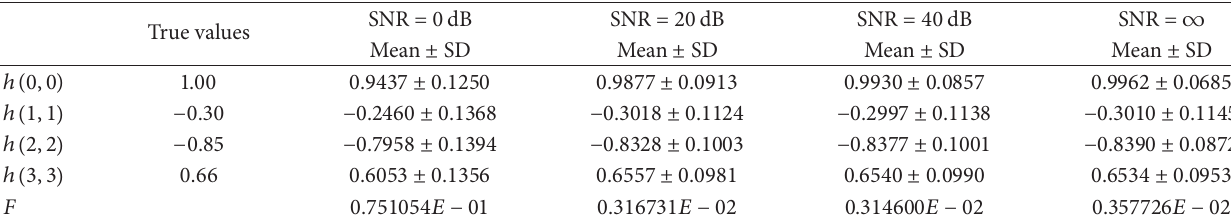
Table 1: Identified results [E1: diagonal element ℎ(𝑖,𝑖) ].